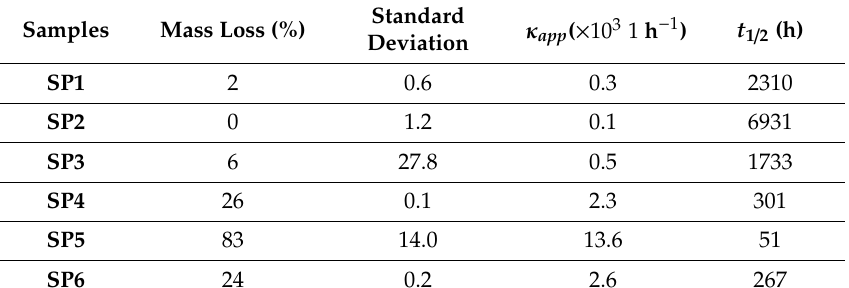
Table 3. Apparent reaction constants ( κ app ) calculated for SP1 to SP6 after 105 h of treatment. Mass loss (%) is the average result from the study carried out in triplicate.